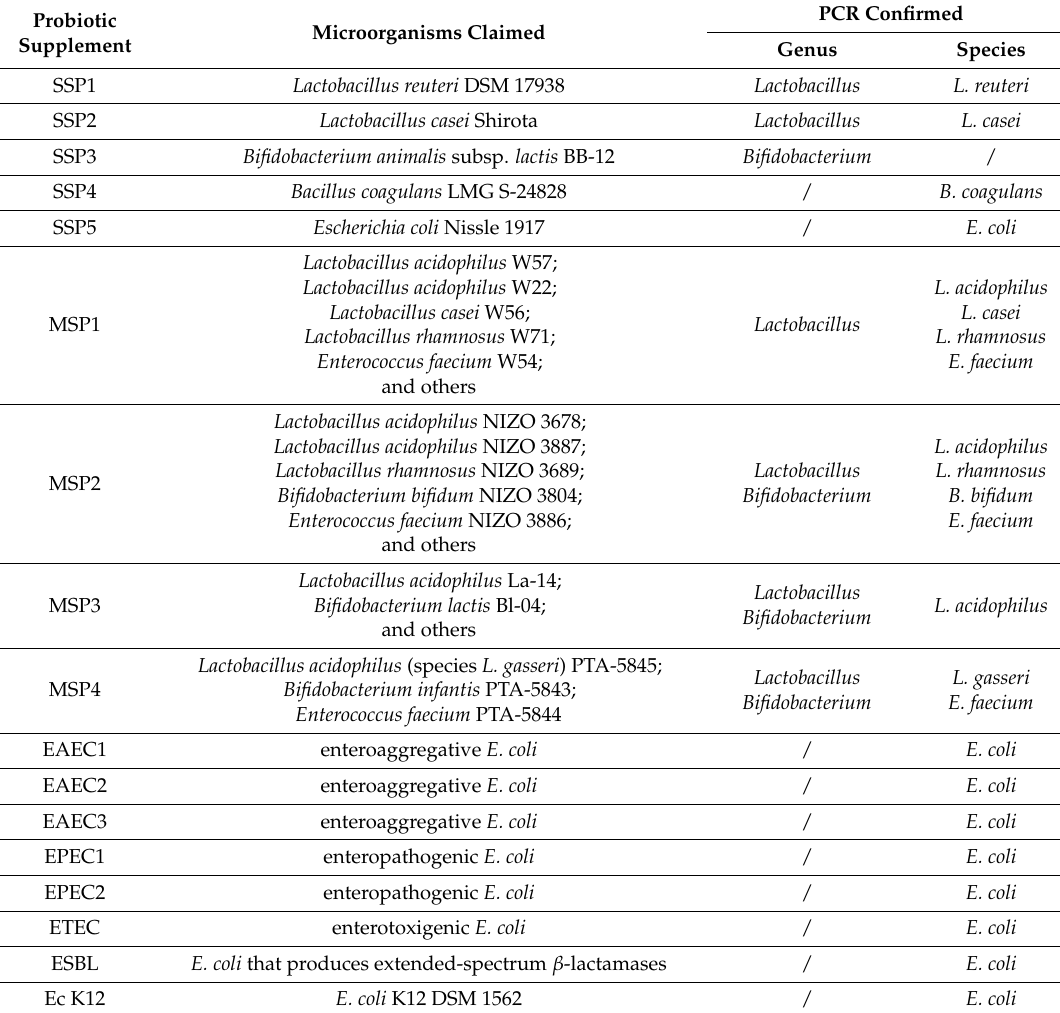
Table 6. Detection of probiotics using genera-specific and species-specific